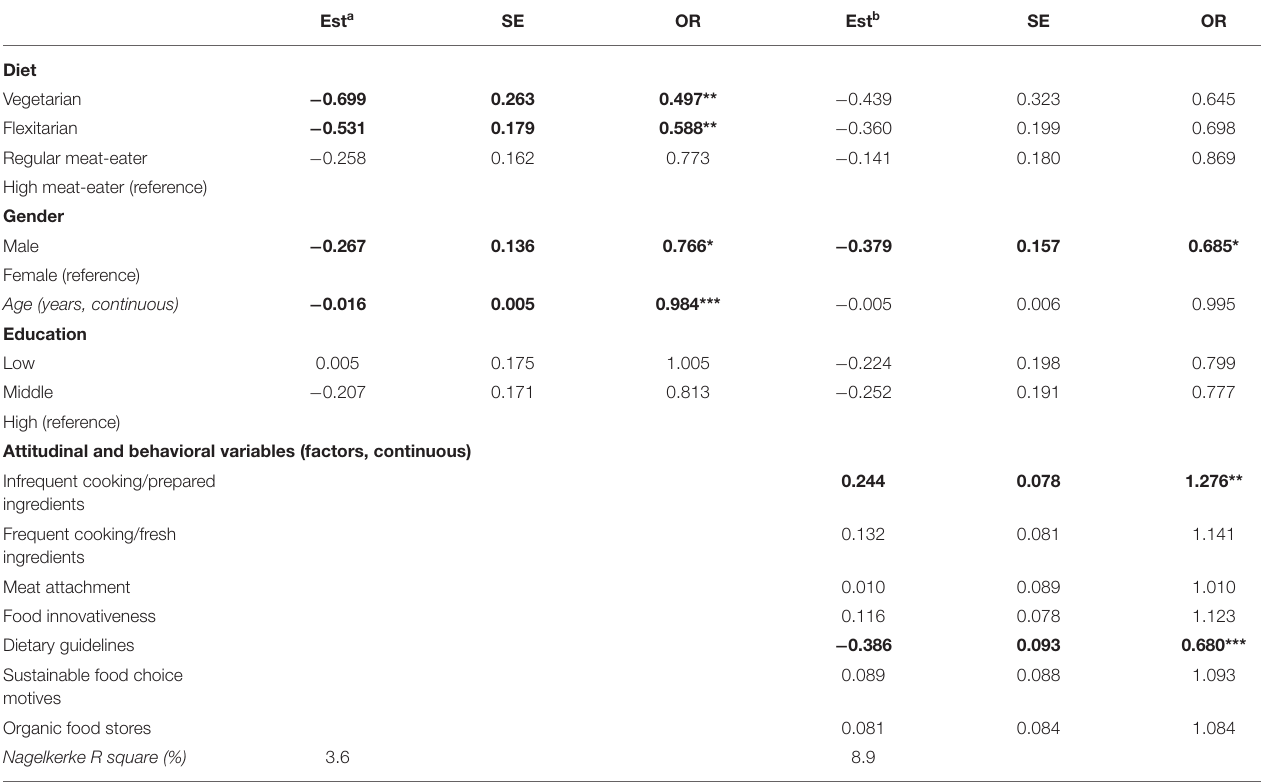
TABLE 9 | Results of an ordinal regression analysis predicting sweet and salty snack consumption ( N =